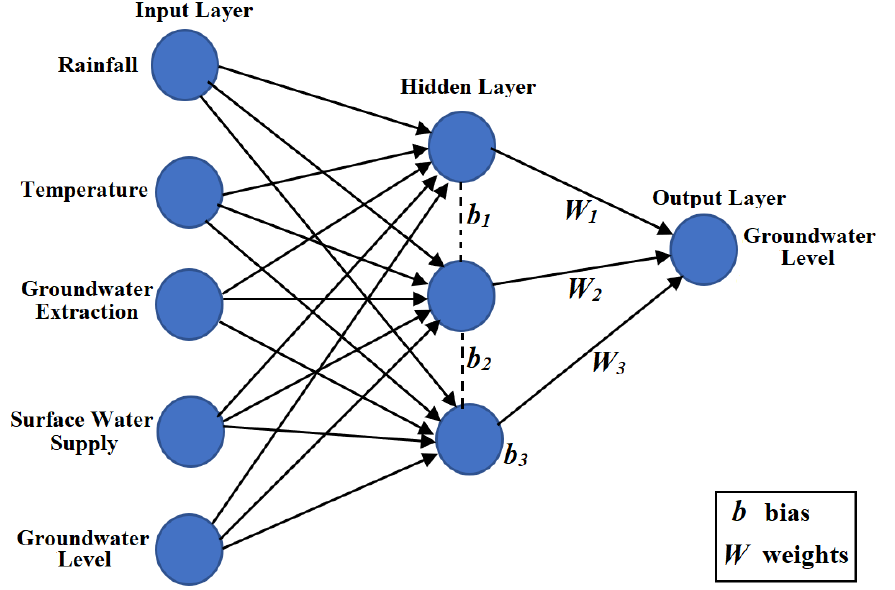
Figure 5. Single-layer neutral network architecture.